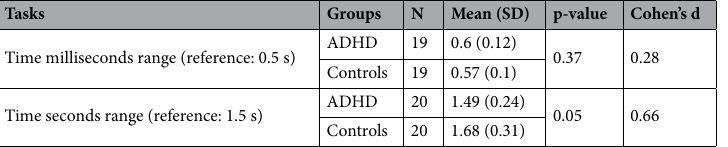
Table 3. Descriptive statistics: point of subjective equality (PSEs). Two tailed t-tests, α Bonferroni corrected 0.05/2 = 0.025.